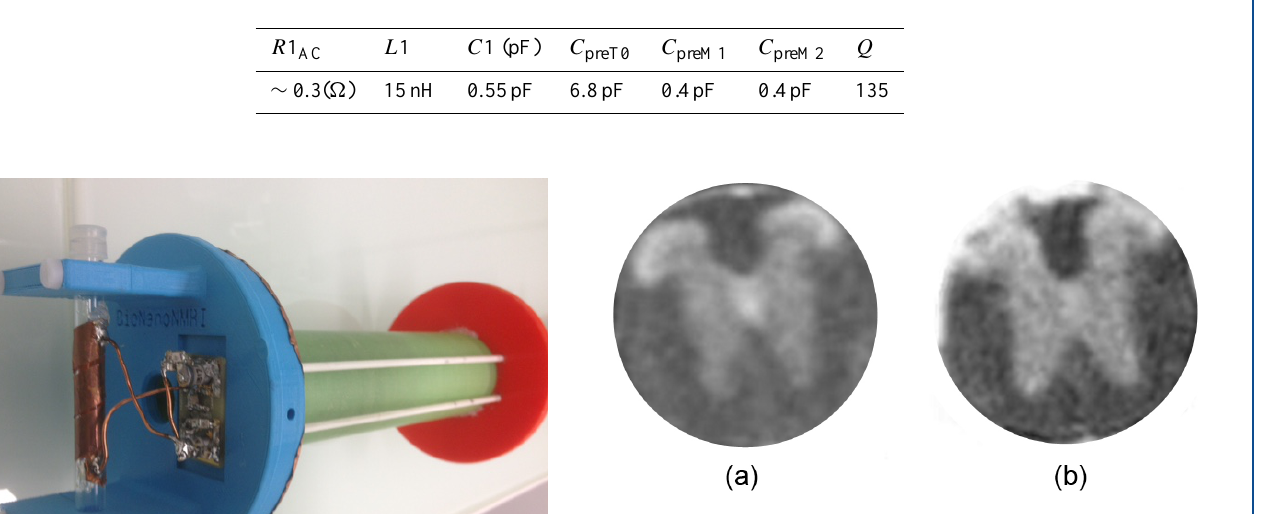
Table 2. Electrical parameter summary.